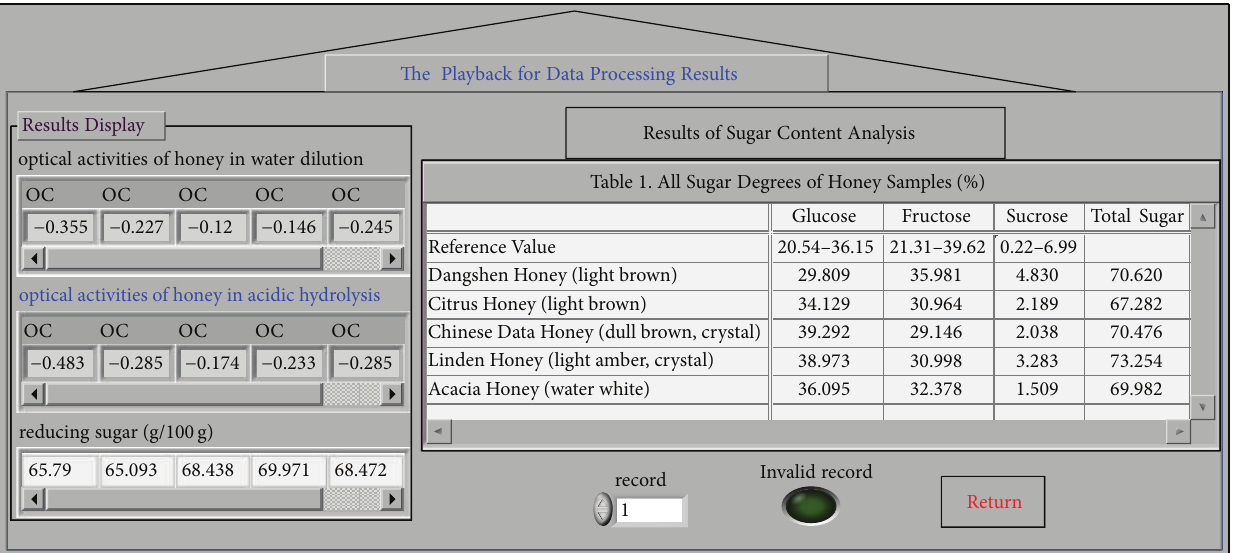
Table 1 . All Sugar Degrees of Honey Samples